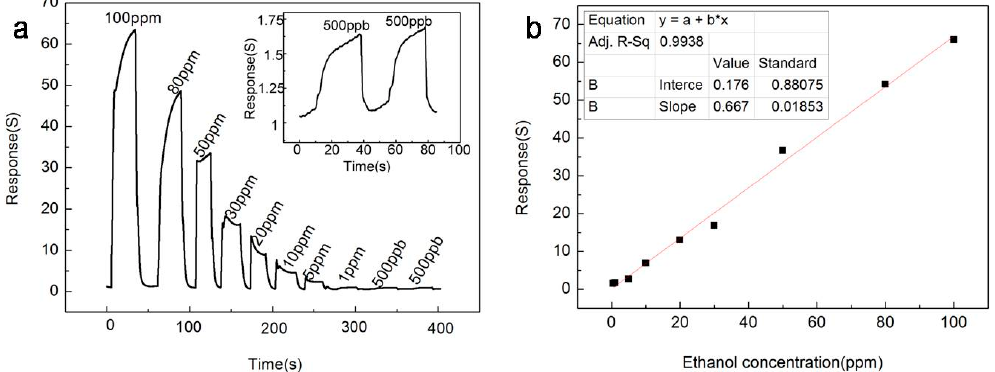
Figure 7. At the optimum operating temperature of 270 °C, ( a ) the response curve of the In 2 O 3 -8 h sensor to ethanol gas at different concentrations; ( b ) The relationship between the In 2 O 3 -8 h sensor response value and ethanol concentration.